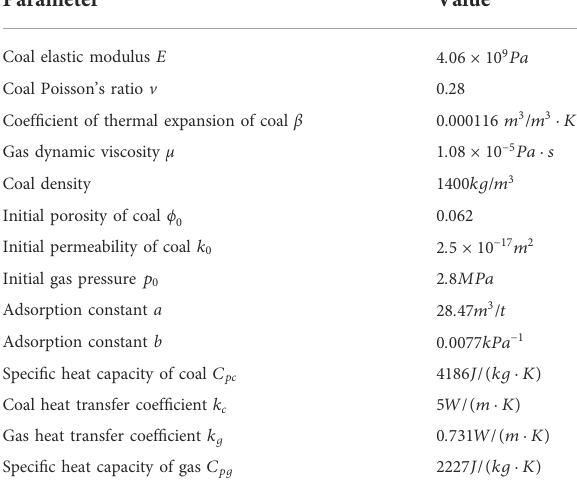
TABLE 3 Calculation parameters of the